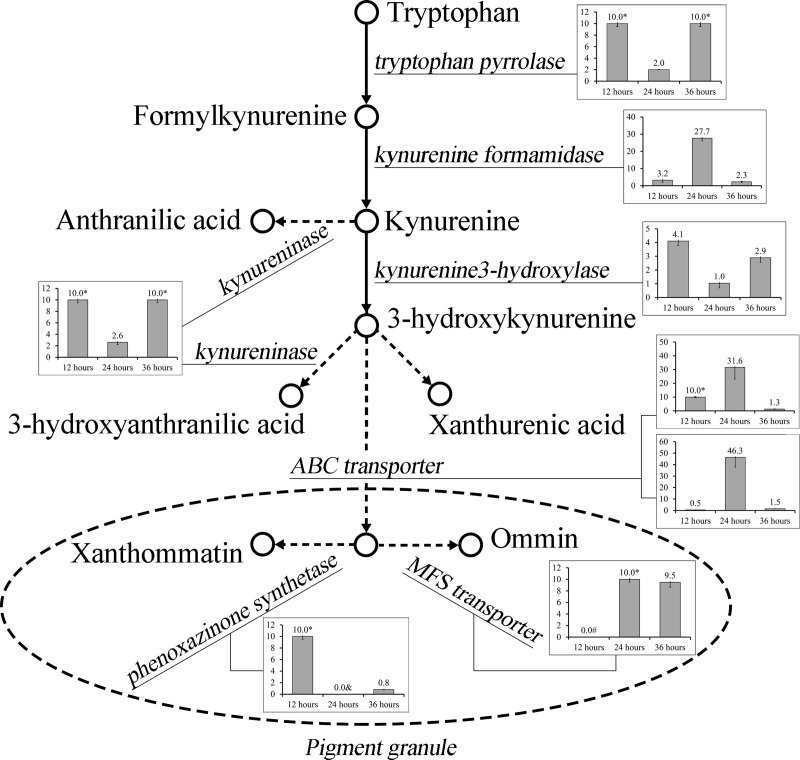
Ommochrome synthesis pathway.Ommochrome is synthesized through a series of enzymatic reactions employing tryptophan as the substrate. Most genes encoding these enzymes were up-regulated in the rep-1 mutant especially at 24h after oviposition. The vertical axis is defined as the ratio of expression of rep-1 mutant / expression of wildtype. If the ratio> 2 or <0.5, it indicates that there are differences in expression quantity.